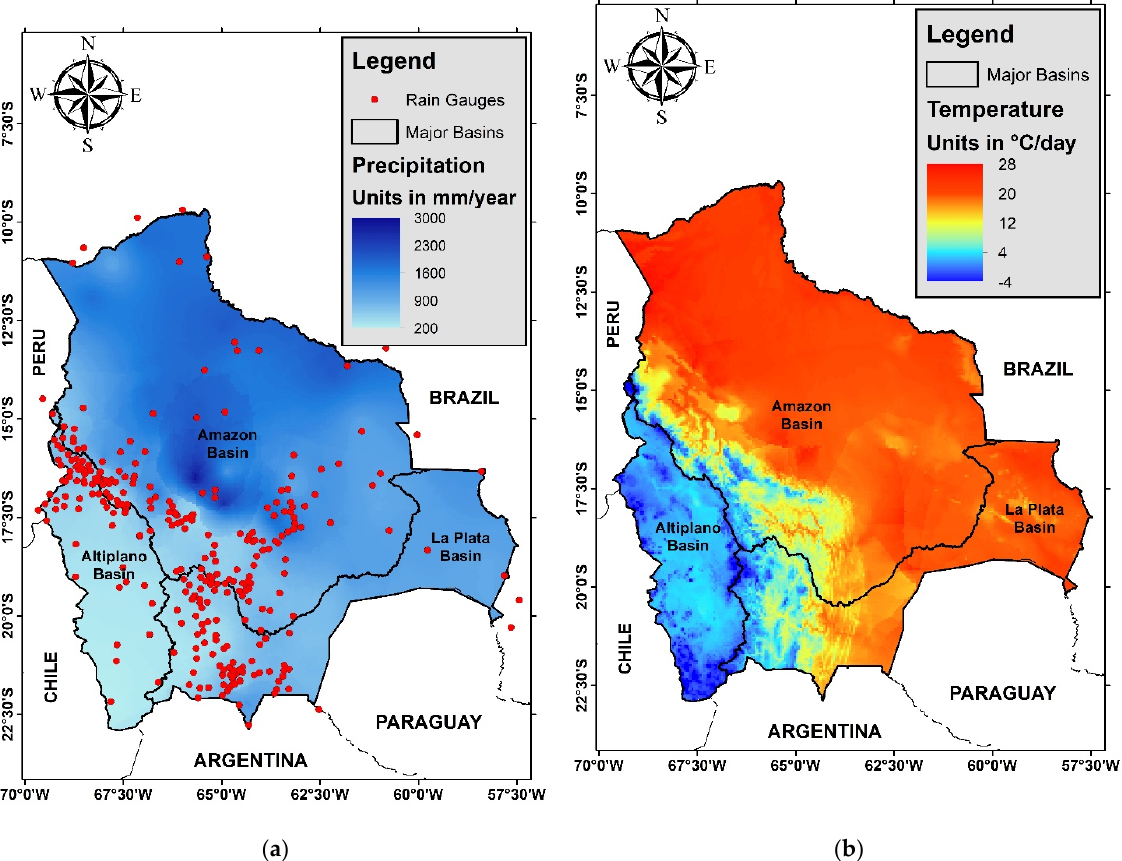
Figure 2. ( a ) Annual mean precipitation map of Bolivia; ( b ) daily mean temperature map of Bolivia for the period 2001–2015. for the period